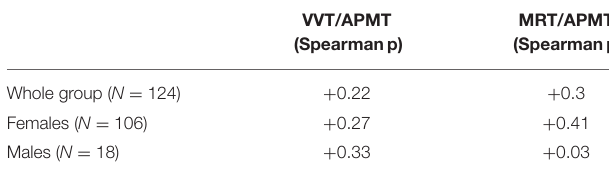
TABLE 2 | Spearman’s GVVT or MRT performance, and APMT test